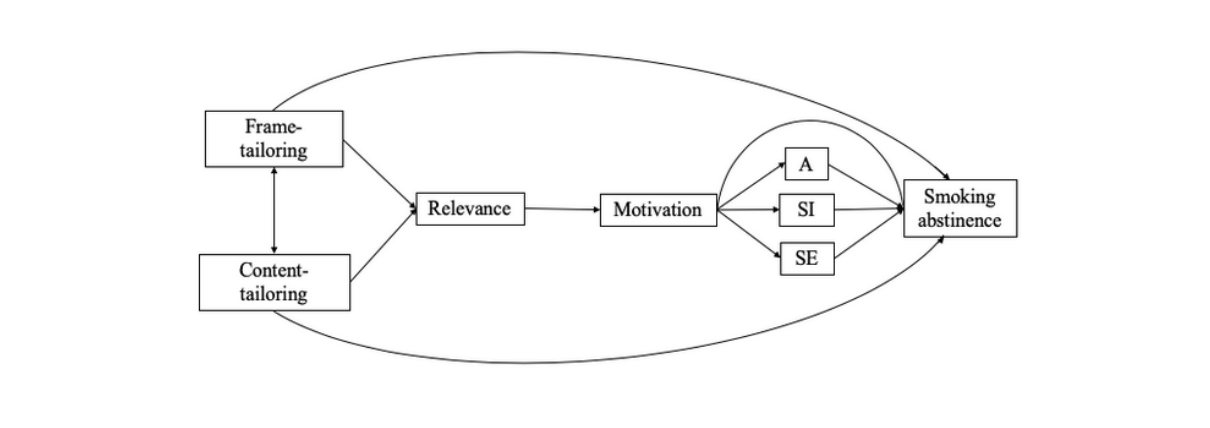
Figure 1. Conceptual model. Smoking abstinence was measured as the 7-day point prevalence of absence of smoking. A, attitudes; SE, self-efficacy; SI, social